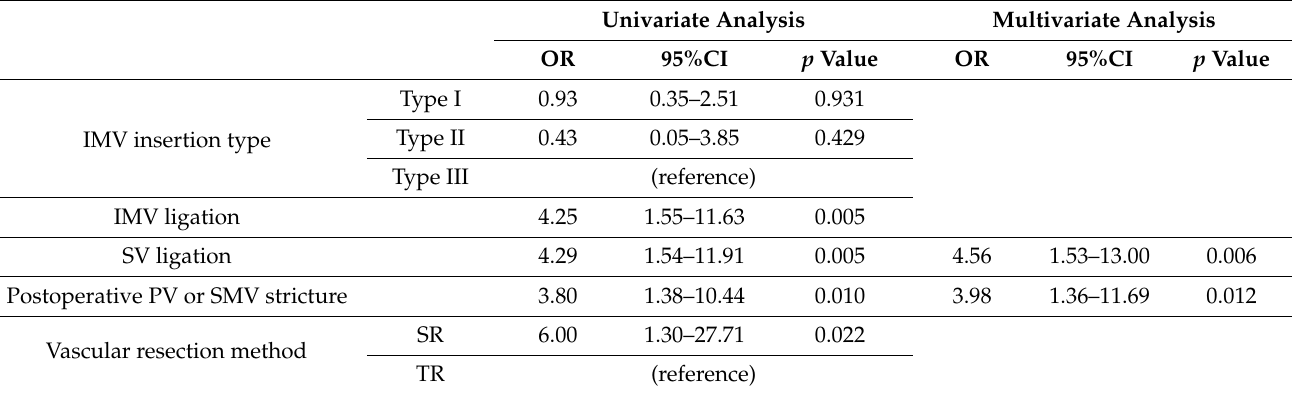
Table 2. Univariable and multivariable analyses for variceal formation after pancreatoduodenectomy.